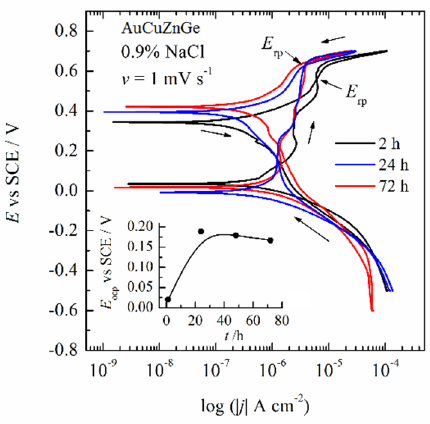
Figure 7. Polarization curves ( v = 1 mV s − 1 ) of the alloy after 2, 24, and 72 h immersion. Inset: The dependence of open circuit potentials over the time of immersion.